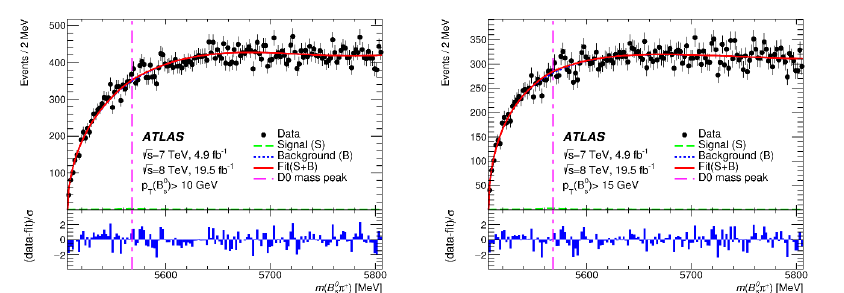
π ± mass distribution for candidates with p T ( B 0 Figure 1: B 0 s GeV (right). The bottom panels show the di ff erence between each data point and the fit divided by the statistical uncertainty of that